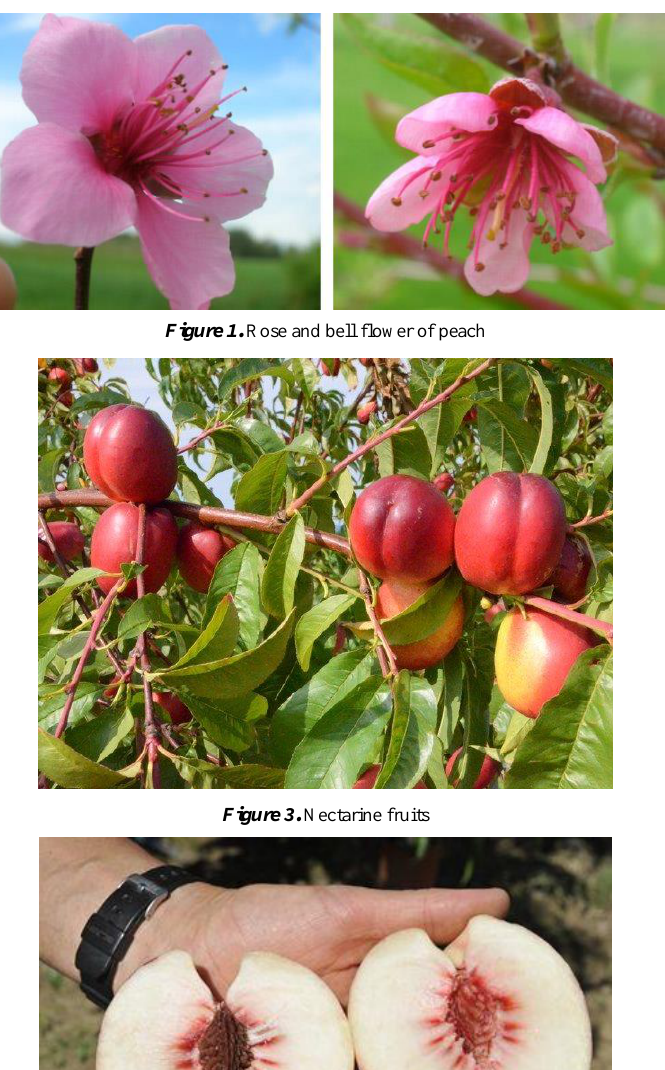
Figure 5. Of white flesh fruit Figure 6. Of yellow flesh fruit